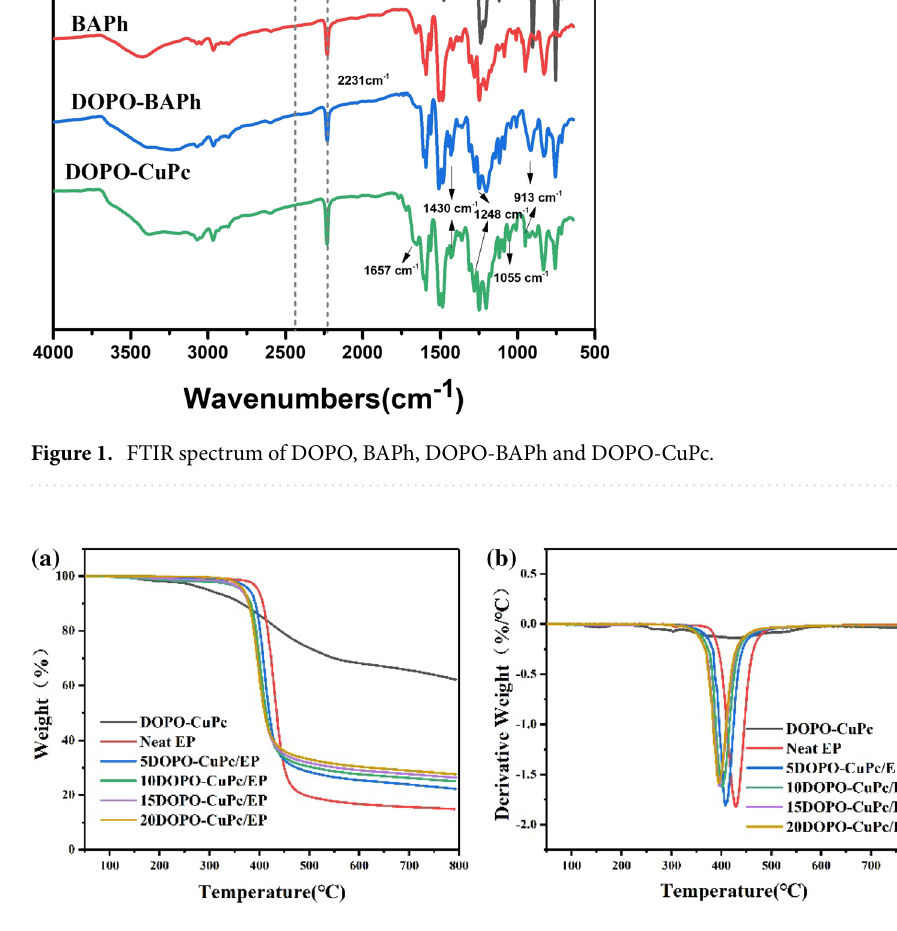
Figure 2. ( a ) TGA and ( b ) DTG curves of DOPO-CuPc and epoxy thermosets under N 2